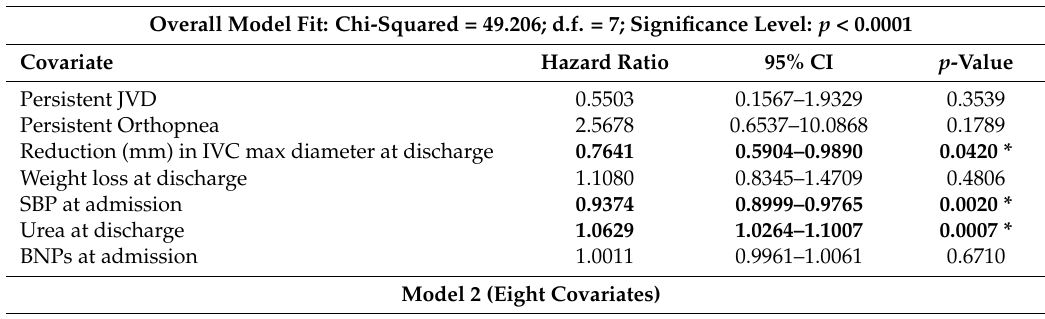
Table 5. Multivariable predictors of six-month all-cause death. Model 1 (Seven